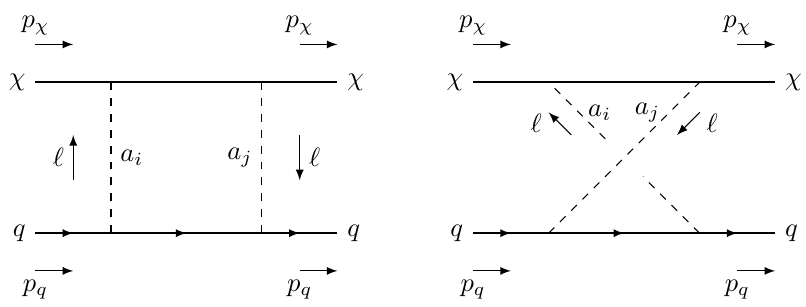
Figure 10 . The box diagrams and their momentum